Question: What does this figure show? Answer in one sentence.
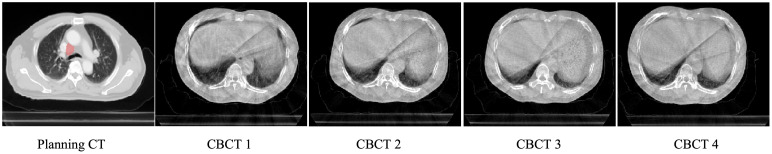
Answer: Representative imaging example from a patient with the cohort-median number of CBCT scans. The planning CT panel shows the axial slice with the largest GTV cross-sectional area, with the original planning GTV displayed as a high-visibility contour. Serial CBCT panels show visually corresponding nearby axial slices acquired during radiotherapy. For methodological rigor, the propagated GTV contour is not overlaid on CBCT images because the registered contour should not be interpreted as the exact tumor boundary on CBCT, particularly in the presence of atelectasis, obstructive inflammation, or treatment-related inflammatory changes.